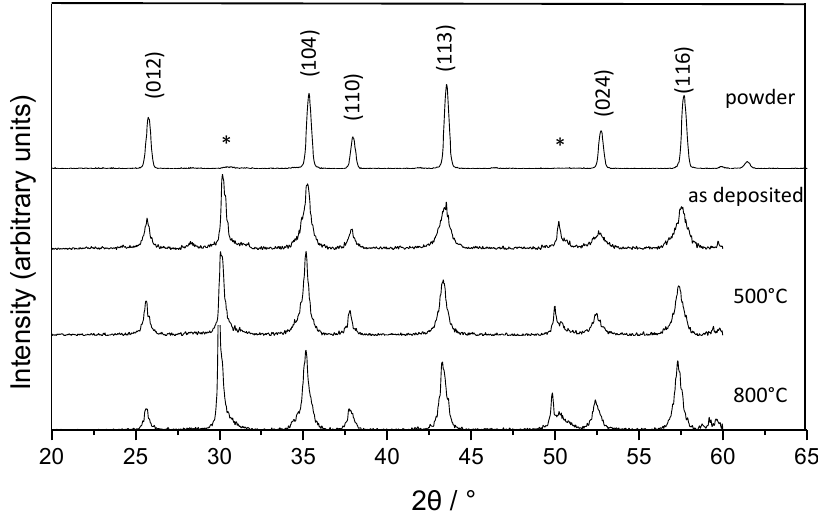
Figure 8. XRD patterns of the raw powder and the AD layer after deposition and while heat treatment at 500 and 800